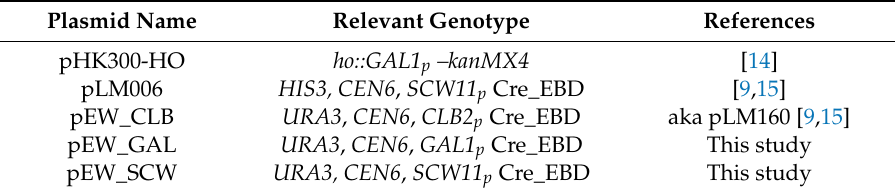
Table 1. Cre-recombinase expression